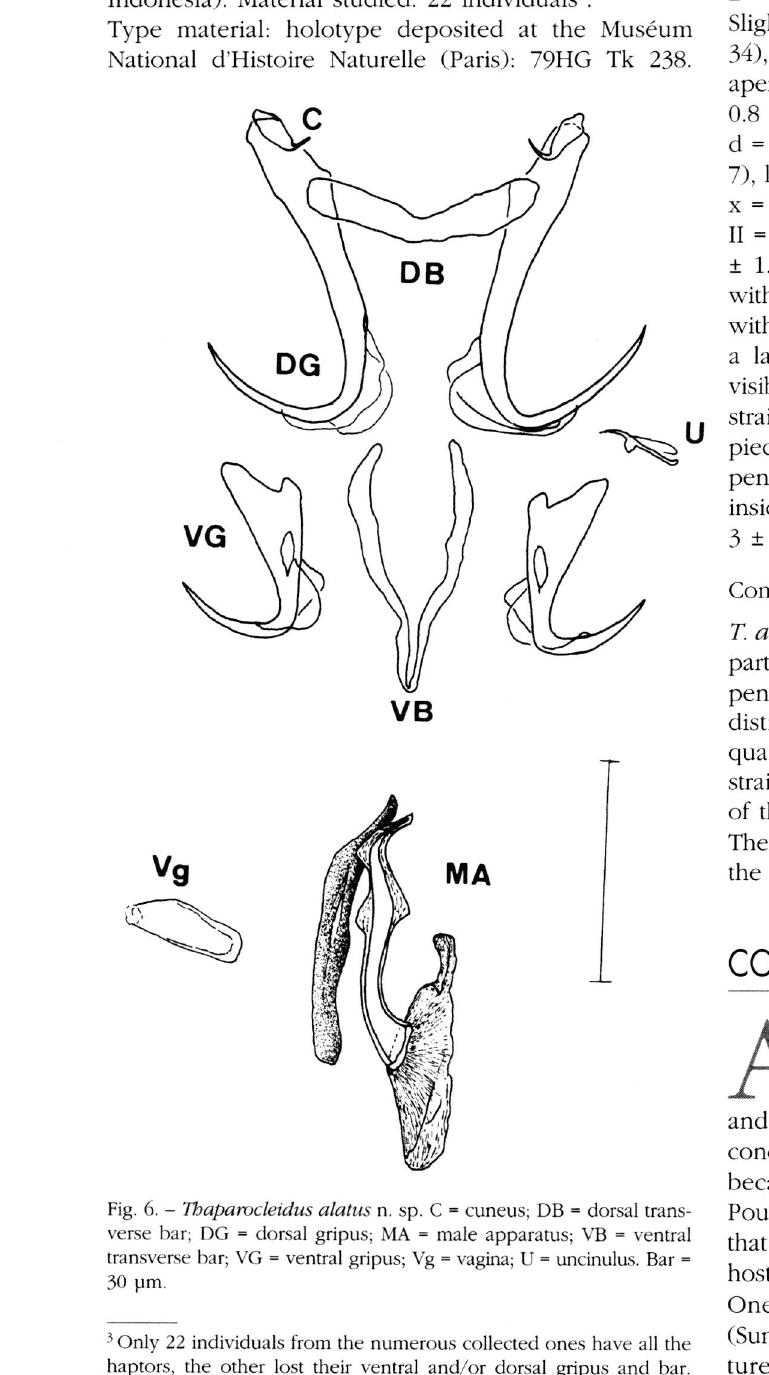
Fig. 6. - Thaparocleidus alatus n. sp. C = cuneus; DB = dorsal trans verse bar; DG = dorsal gripus; MA - male apparatus; VB = ventral transverse bar; VG = ventral gripus; Vg = vagina; U = uncinulus. Bar = 30